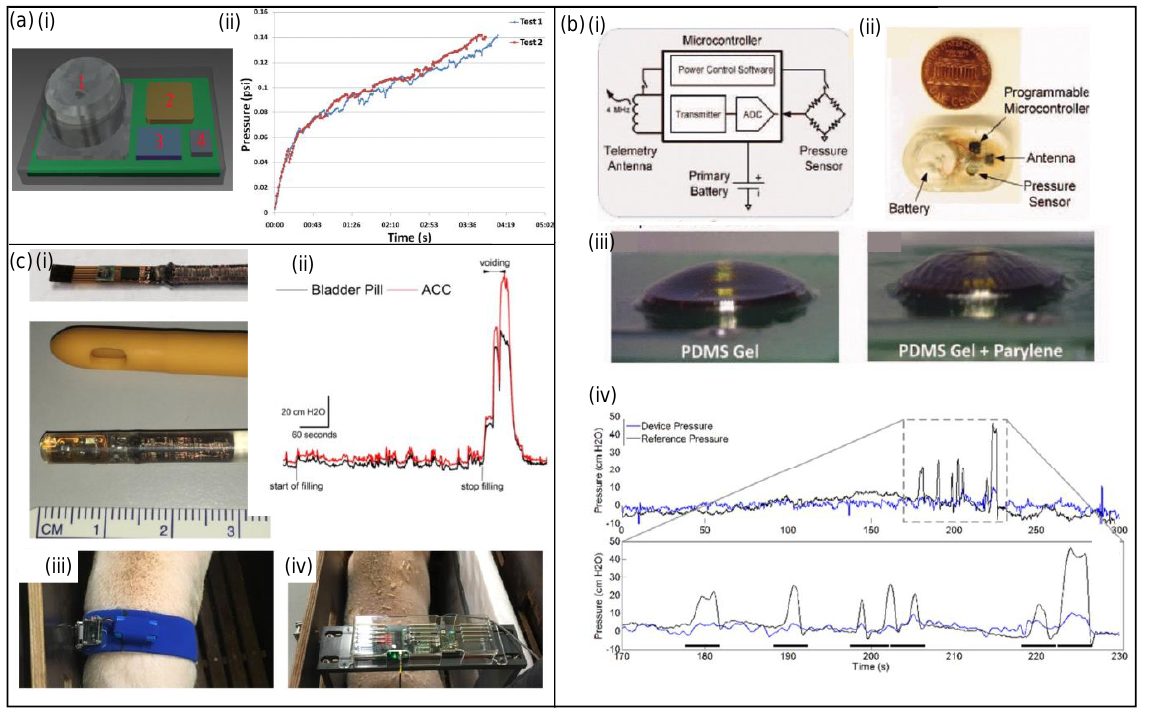
Figure 7. Bladder − monitoring devices. ( a , i ) The schematic of the pressure sensor CAD design. Com- ponent 1 is an MS5534C miniature pressure sensor, component 2 is the ATtiny43u microcontroller, component 3 is the ZL70101 transmitter, and component 4 is a standard oscillator to be used for the miniature pressure sensor; ( ii ) a pressure − time curve [62]. Copyright 2010, IEEE. ( b , i ) The wireless pressure sensor circuit diagram, ( ii ) the size compared to a coin, ( iii ) the different polymer coatings, and ( iv ) graphs of catheter and wireless pressure monitoring pressure recordings versus time [93]. Copyright 2016, IEEE. ( c , i ) The bladder pill device, the non − encapsulated and the encapsulated bladder bill, ( ii ) details of a single void marked on a graph, ( iii ) the waistband device, and ( iv ) rectangular frame setup [94].